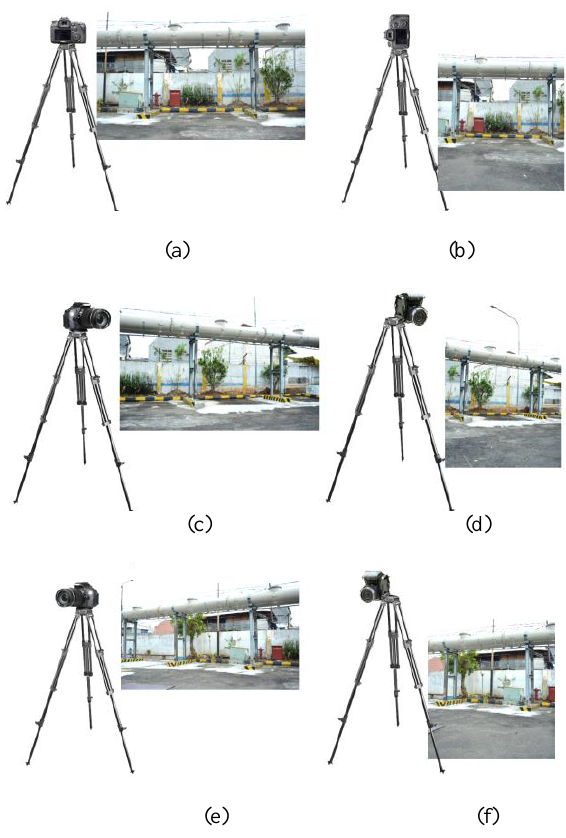
Figure 9. Taking photos with (a) portrait straight shot, (b) landscape straight shot, (c) right-oblique portrait shot, (d) right- oblique landscape shot, (e) left-oblique portrait shot, and (f) right-oblique landscape